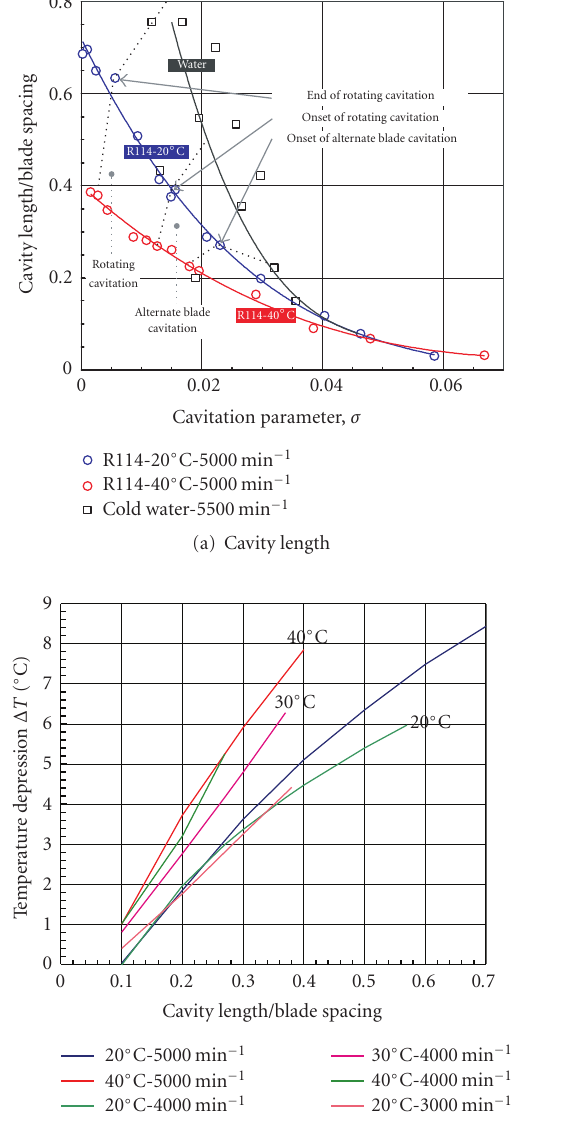
Figure 3: Experimental results in the case of R-114 and cold water (Franc et al. [2]).